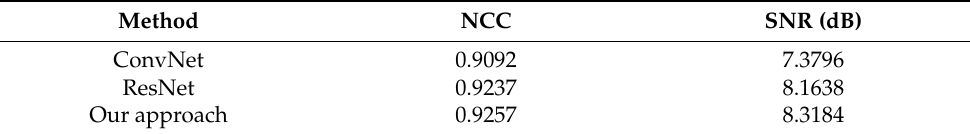
Table 5. Quantitative evaluation of the MT data denoised by different methods.